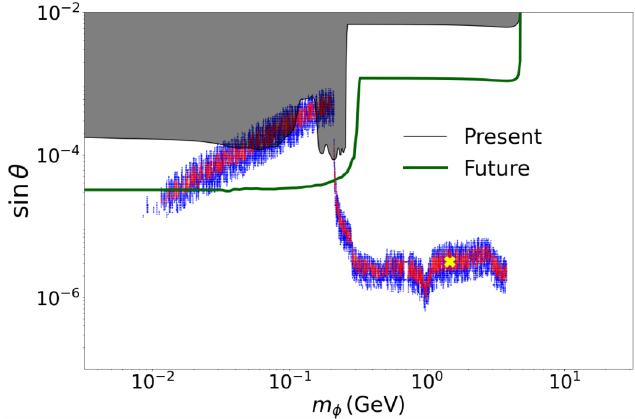
Figure 5 . The prediction of the scalar dark matter model that is obtained by casting the favored parameter sets in section 3.5 onto the ( m φ , sin θ ) -plane with C hχχ = C φφh = 0. The colors used for the prediction, i.e., red, blue points, and the yellow crossing mark, are the same as those in figure 4. The constraint from present direct dark matter detection experiments and expected sensitivities from future experiments are shown as a gray-shaded region and a dark-green line,